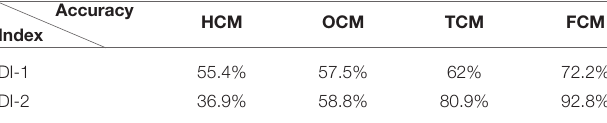
TABLE 5 | Accuracy of damage extent identification according to the statistical